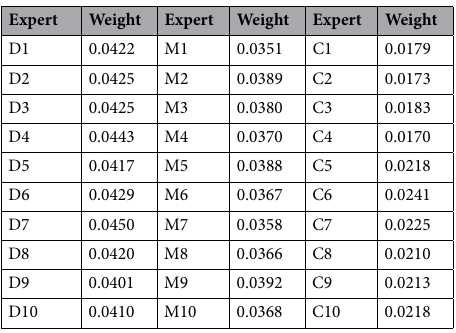
Table 9. Determined expert weight by the proposed